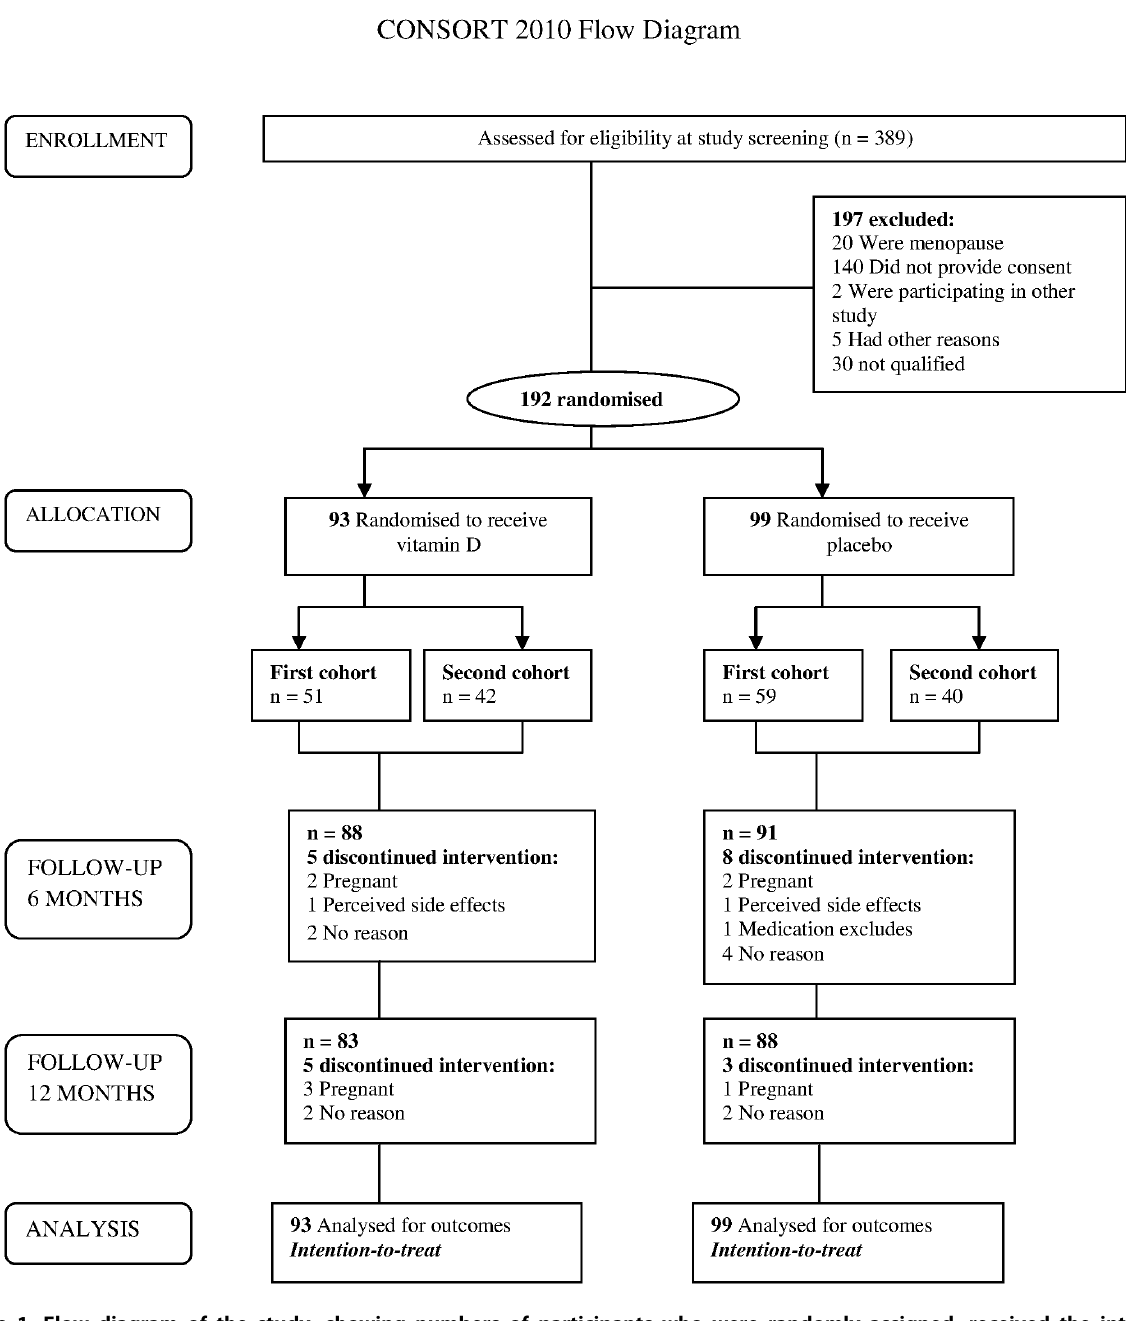
Figure 1. Flow diagram of the study, showing numbers of participants who were randomly assigned, received the intended treatment and were analyzed for the primary outcomes.